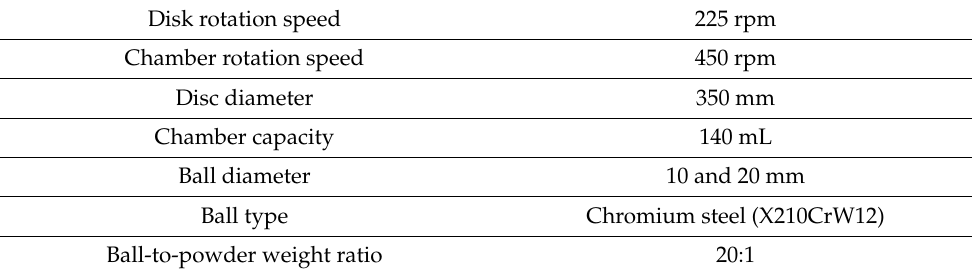
Table 1. Specifications of the milling machine and the milling variables.